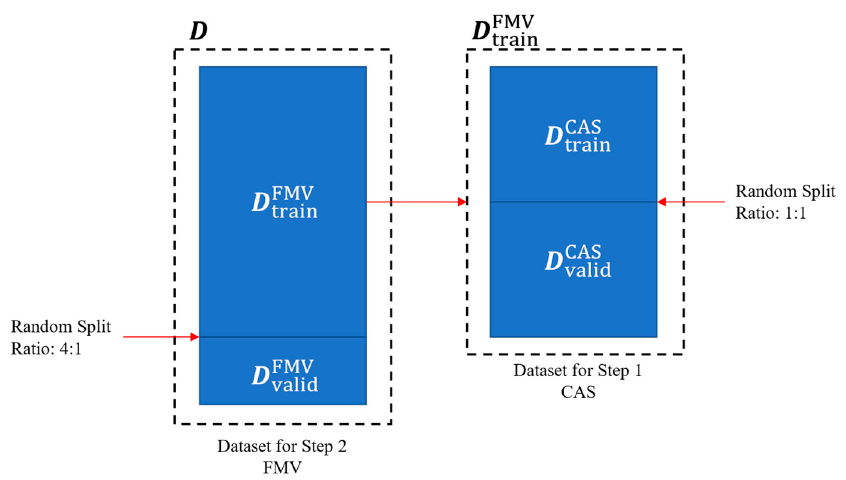
Figure 9. Schematic of dataset division.